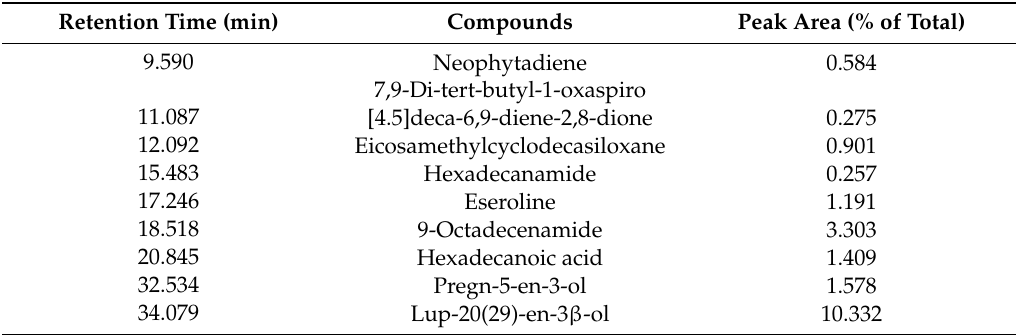
Table 5. Phytocomponents identified in the crude methanolic extract of P. angolensis leaves by GC-MS.